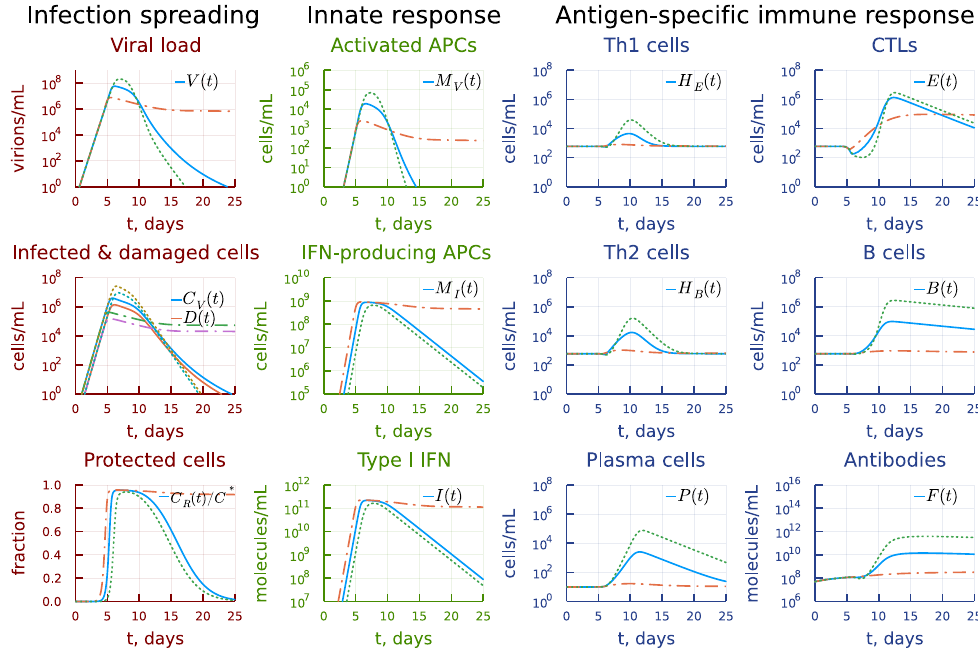
Figure 9. Effect of the rate constant of the activation of type I IFN response. Dashdot: 10-fold increase of γ M , dot: 10-fold decrease of γ M I